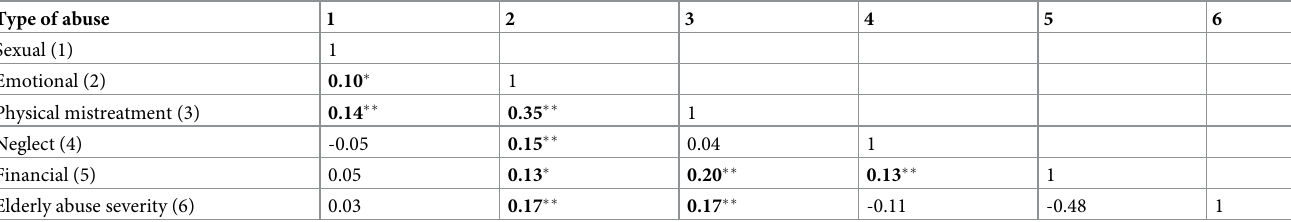
Table 4. Correlation between the different types of abuse and elderly abuse